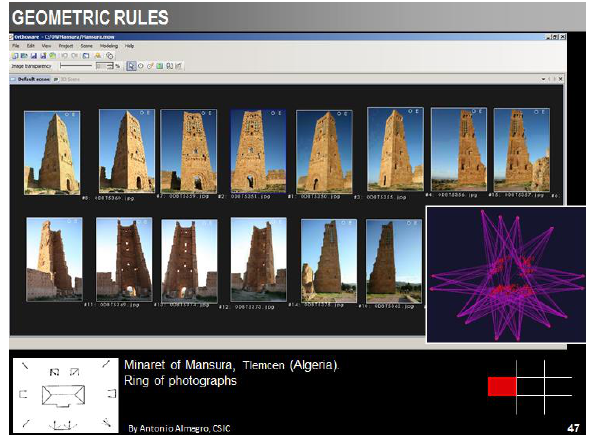
Figure 8. One of the geometric rules as part of the 3x3 rules: the ring of images around the subject. The Geometric rules were stressed as critical to ensure complete coverage of the monuments at risk. Participants practiced this and the other rules during the courses and they were shown how this ring of images, if correctly captured, could be further processed later as rectified images or even 3D models (Almagro,